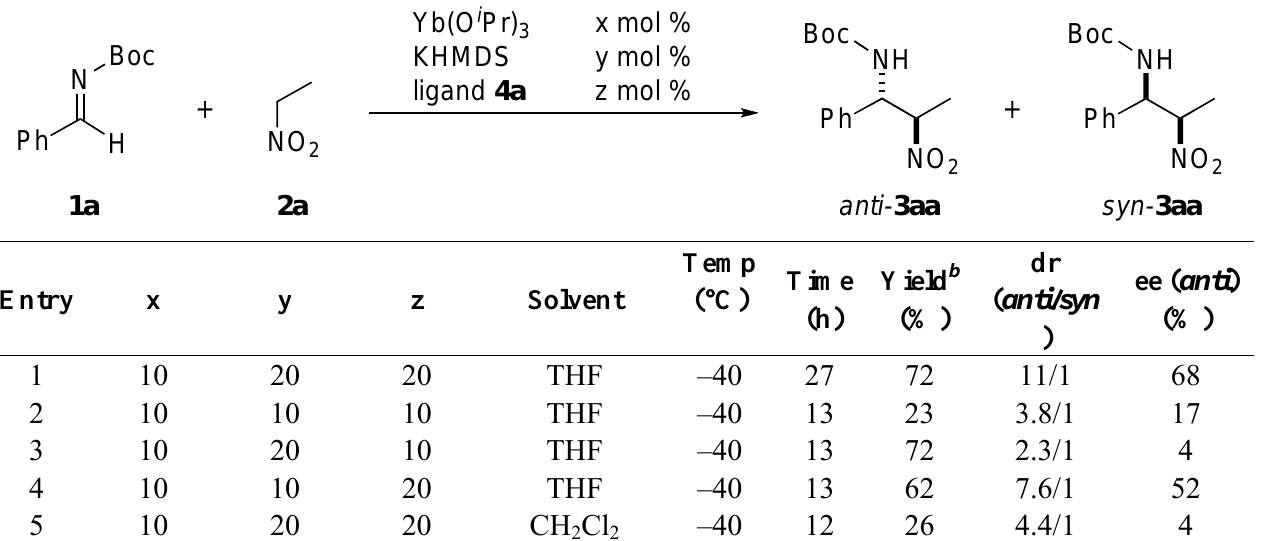
Table 4. Optimization of reaction conditions based on Yb/K/ 4a heterobimetallic catalyst.